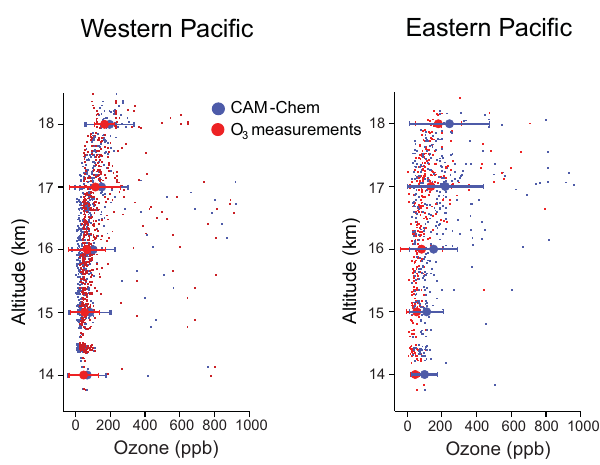
Figure 2. NOAA–UCATS O 3 observations for all flights (blue dots) and CAM-Chem simulations along ATTREX flight tracks (red dots). Filled circles represent the mixing ratios averaged into 1km altitude bins ± 1 SD over the WP and EP to illustrate the altitude variation of ozone. The range of the bins are as follows: 14km is 13.5–14.5km, 15km is 14.5–15.5km, 16km is 15.5 –16.5km, 17km is 16.5–17.5km, and 18km is 17.5–18.5km. Similar figures for CH 2 Br 2 and CHBr 3 are in Navarro et al. (2015).